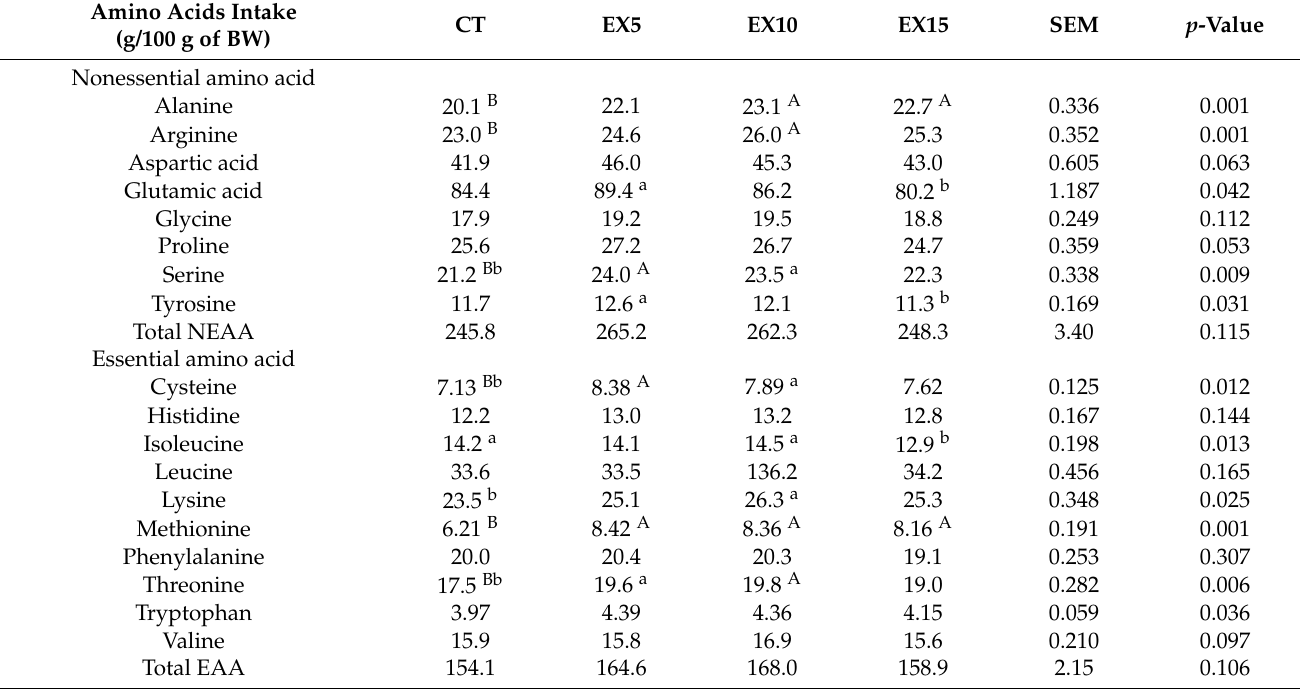
Table 5. Calculated average daily intake of amino acids by male 43-day-old Ross-308 broilers (Mean, SEM, n =